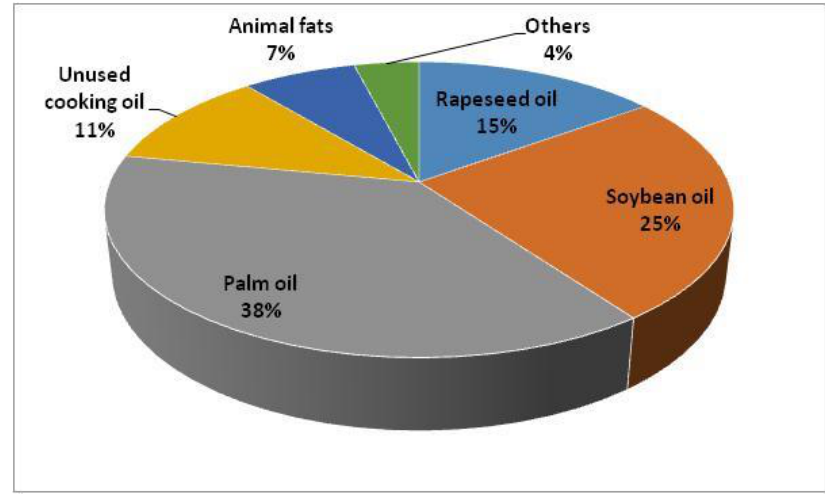
Figure 10. Different feedstock used for biodiesel production. Table 1. Lipid/oil content in non-edible low-cost feedstocks used for chemical and biochemical processes. Feedstock Oil/Lipid Content (%) Food waste 5–55 Spent coffee grounds 15 Municipal sewage sludge 12–18 Microalgae biomass 20–50 a Pongamia 30–40